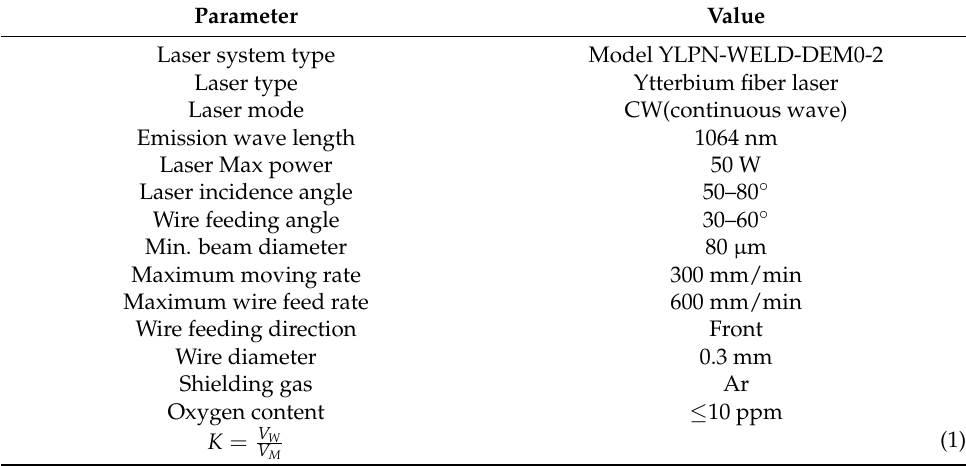
Table 2. Characteristics of LJWF-DMD AM system.